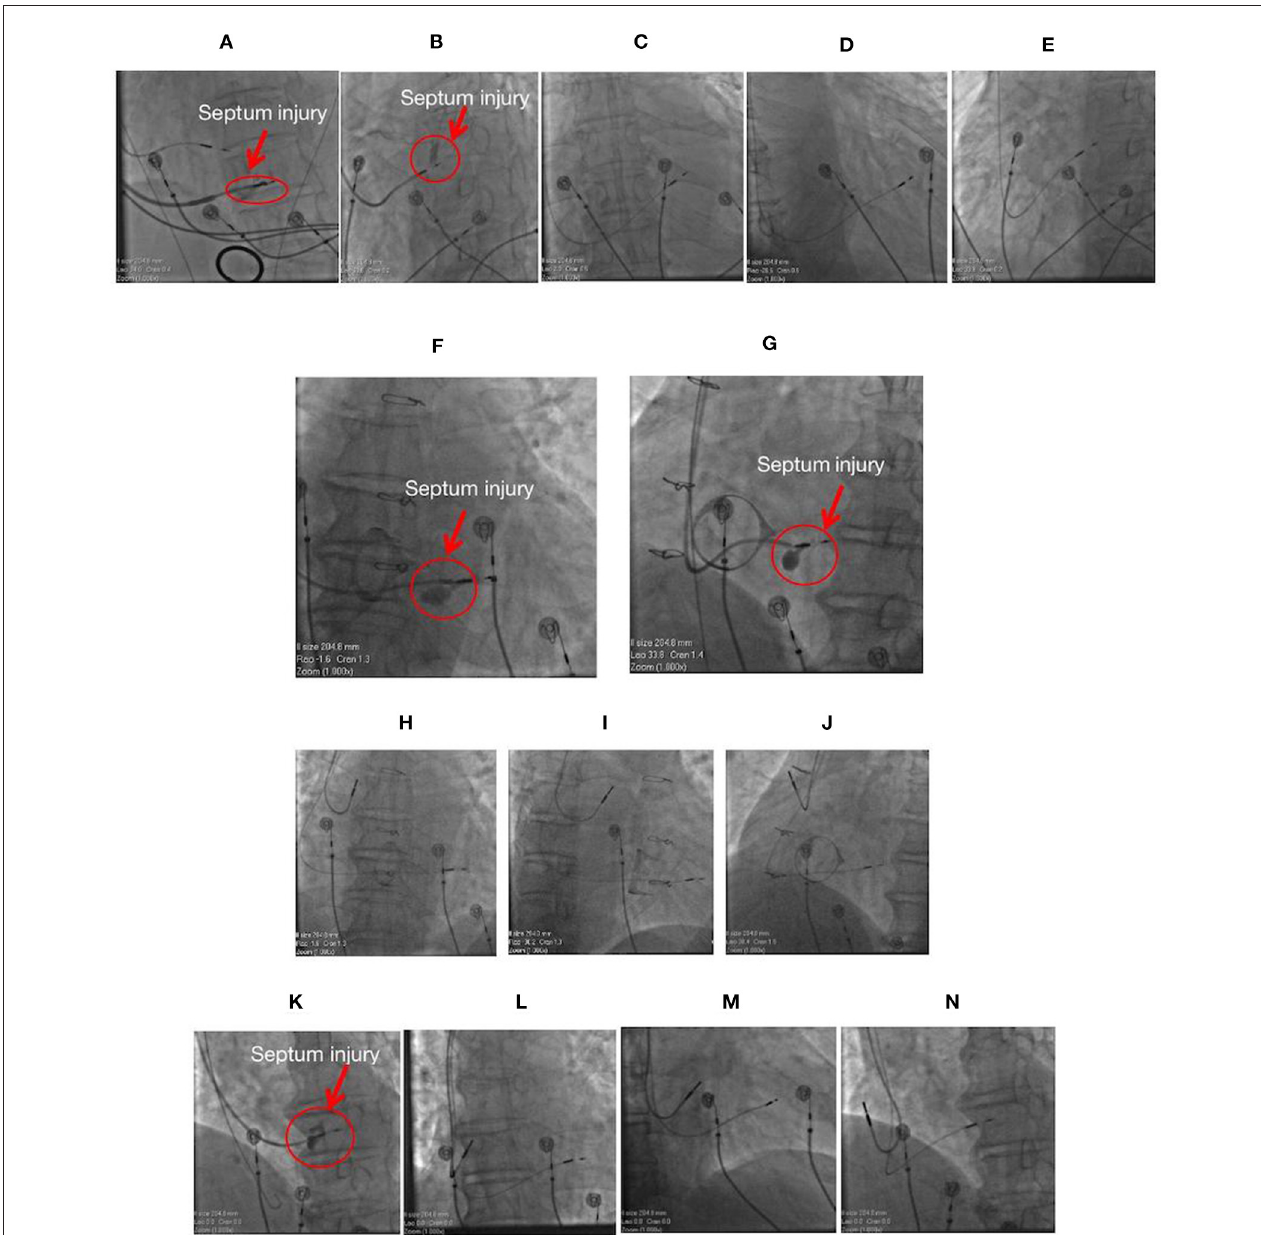
FIGURE 5 | Images of four cases with septum injury during the procedure. (A) The fluoroscopic image of a 71-year-old female having mitral regurgitation and sick sinus syndrome with ventricular septum injury (red arrow) during LBBP lead implantation at LAO 35 ◦ . (B) The fluoroscopic image of a 77-year-old male with atrial fibrillation and complete AVB with septum injury (red arrow) during LBBP lead implantation with a single-chamber pacemaker at LAO 35 ◦ . The lead was not repositioned, and its location is illustrated at PA (C) , RAO30 ◦ (D) , and LAO 35 ◦ (E) . Fluoroscopic images of a 64-year-old male with sick sinus syndrome post- bioprosthetic tricuspid valve replacement having septum injury (red arrow) during LBBP lead implantation with a dual-chamber pacemaker at PA (F) and LAO 35 ◦ (G) . The lead was not repositioned, and its location is illustrated at PA (H) , RAO30 ◦ (I) , and LAO 35 ◦ (J) . (K) The fluoroscopic image of an 85-year-old male with complete AVB and atrial fibrillation having septum injury (red arrow) during LBBP lead implantation with a dual-chamber pacemaker at LAO 35 ◦ . The lead was not repositioned, and its location is illustrated at PA (L) , RAO30 ◦ (M) , and LAO 35 ◦ (N) . LBBP, left bundle branch pacing; AVB, atrioventricular block; PA, posteroanterior; LAO, left anterior oblique; RAO, right anterior